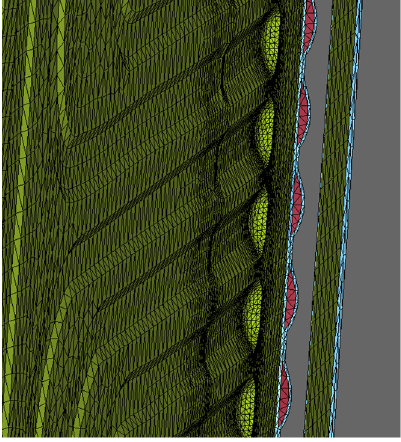
Figure 5. Meshing in inlet channels in DEP MeshWorks 8.0.